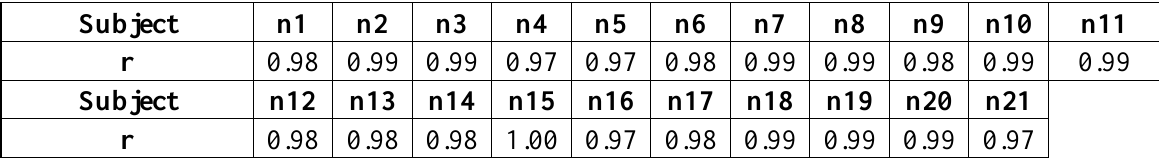
Table 1. Correlation coefficient r for the force-MC signal relationship. These values were measured simultaneously during isometric elbow flexion (90°) for 21 male subjects on the non-dominant